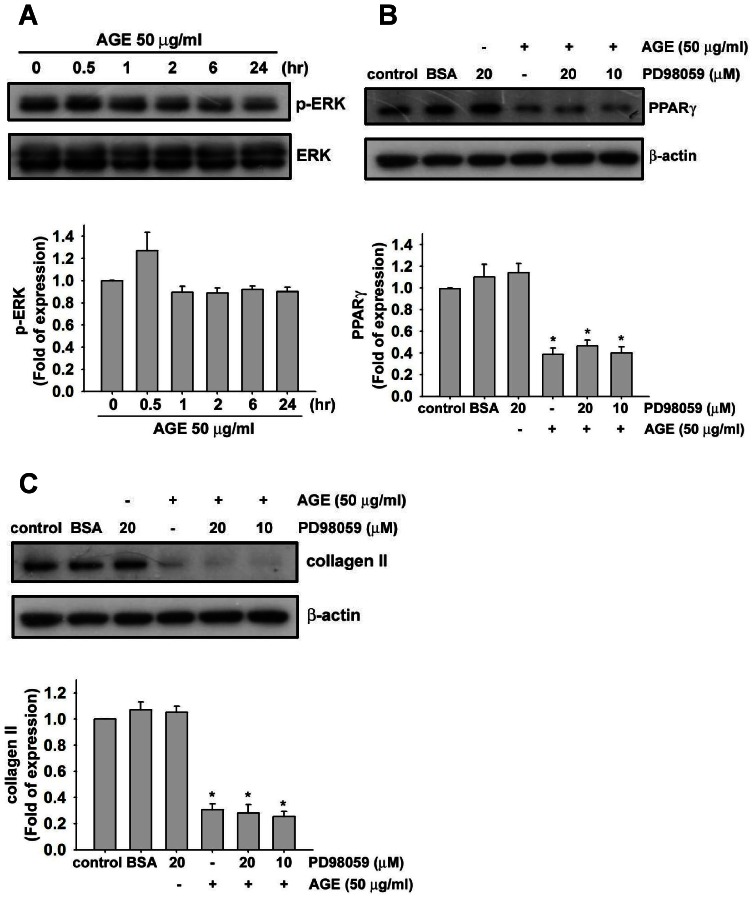
ERK signaling is not involved in the effects of AGEs on chondrocytes.Human OA chondrocytes (1 ×106/ml) were incubated with AGEs (50 µg/ml) for 0.5–24 hours (A) or 24 hours (B,). The phosphorylation of ERK (A) were determined by Western blotting. In B and C, chondrocytes were pretreated with PD98059 (10 and 20 µM) for 1 hour followed by treatment with AGEs for 24 hours. Protein expressions of PPARγ and collagen II was determined by Western blotting. Densitometric analysis for p-ERK, PPARγ and collagen II levels corrected to ERK, β-actin, and β-actin, respectively, is shown. All data are presented as mean ± SEM for three independent experiments. *: P<0.05 versus control.